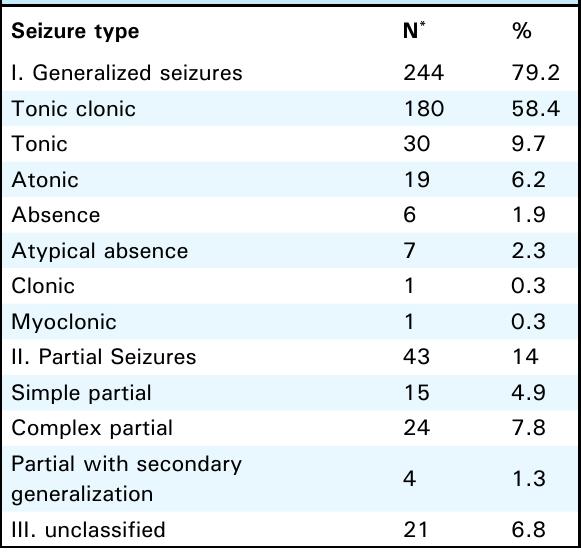
Table 2. Classification of seizure types.